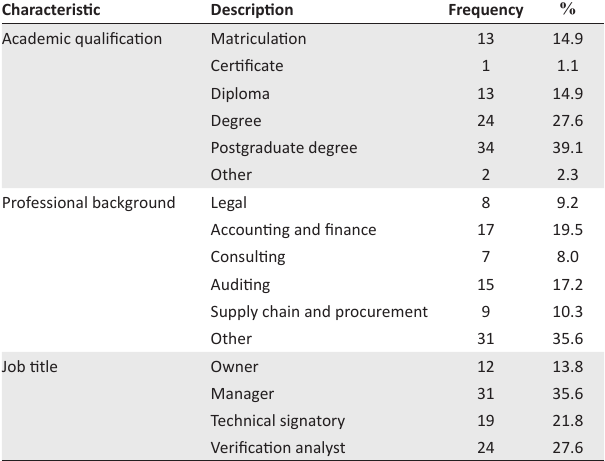
TABLE 3: Professional profile of the respondents. Characteristic